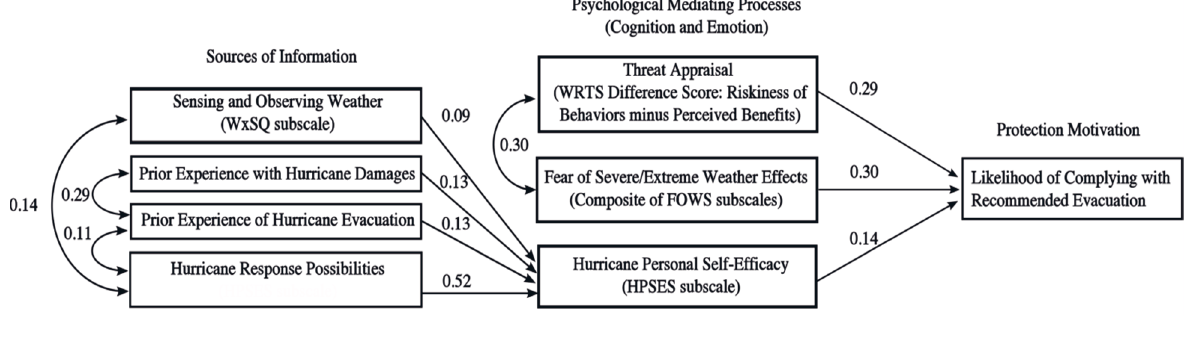
Figure 2. Path model operationalizing selected variables of Protection Motivation Theory to predict likelihood of evacuation. All path coefficients shown differed significantly from